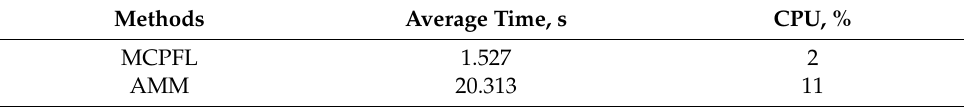
Table 5. Computational